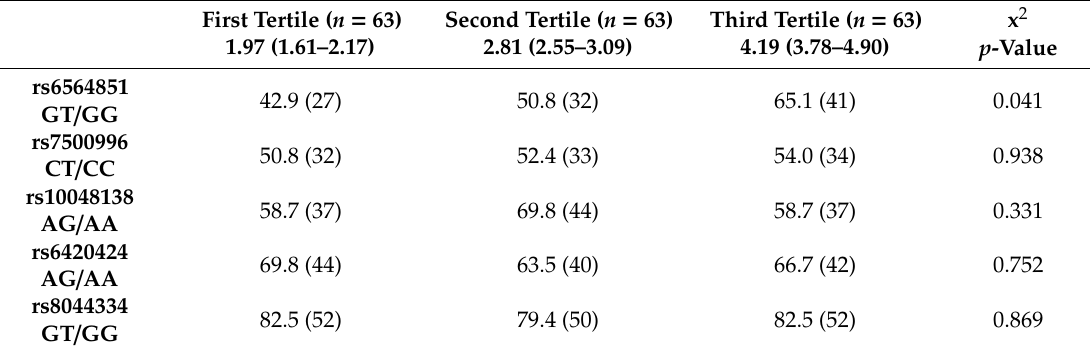
Table 3. Distribution of the alleles known to decrease the conversion e ffi ciency of β